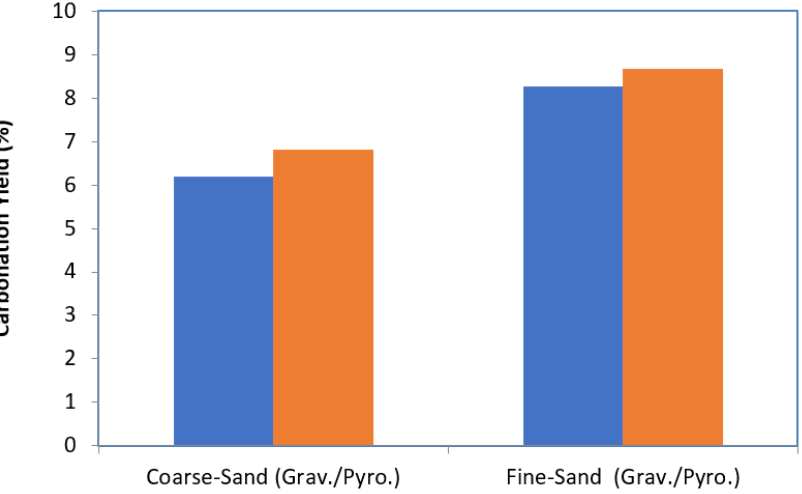
Figure 3. Comparisons of carbonation yields obtained from gravimetric and pyrolytic analysis (5 bar pressure, 104 h curing time and 6 h carbonation time) .